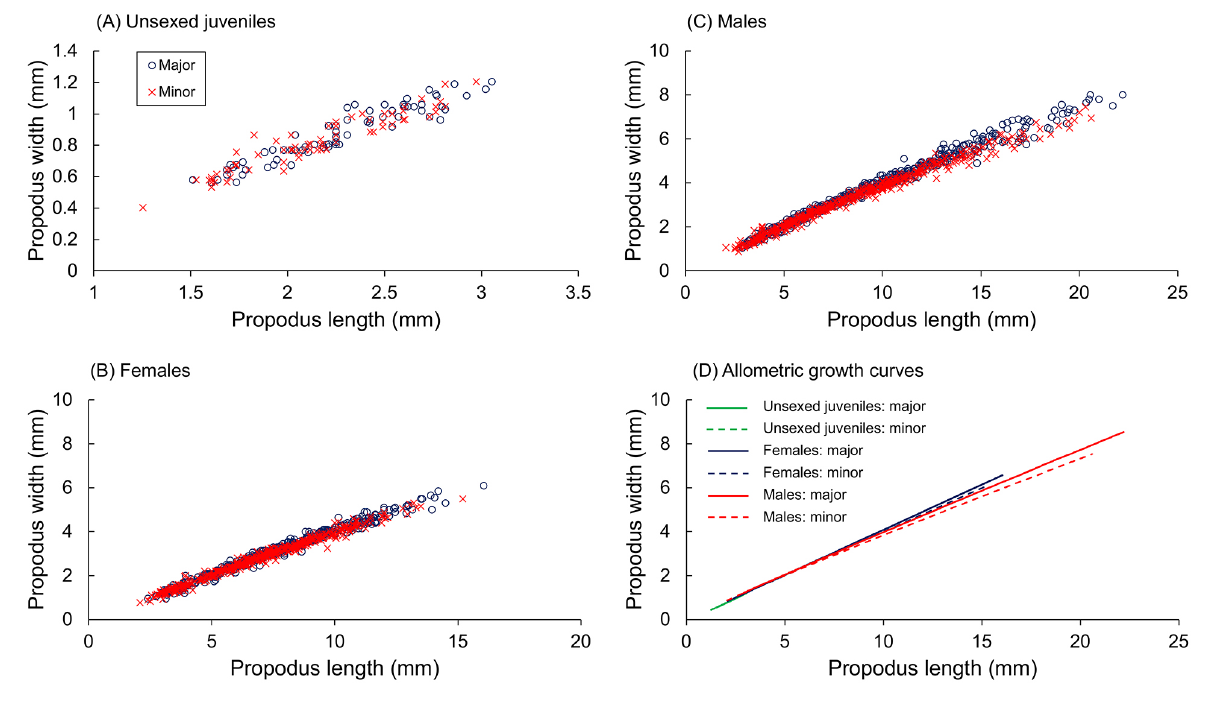
Figure 2. Growth of the propodus width relative to the propodus length of the major and minor chelipeds in unsexed juveniles (A) , females (B) and males (C) of the porcellanid crab Petrolisthes japonicus . Allometric growth curves derived from the log-transformed regression equations of major and minor chelipeds (Tab. 1) are shown for the respective groups (D)